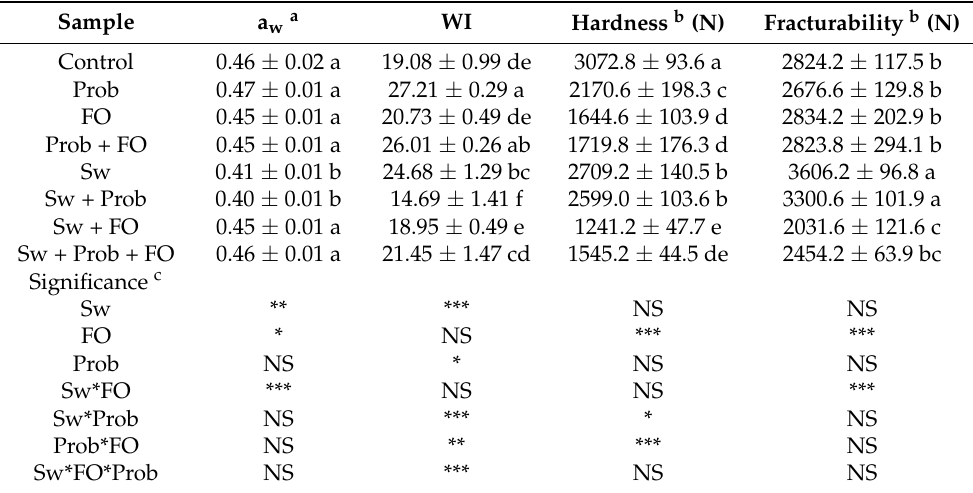
Table 2. Water activity (a w ), whiteness index (WI), and texture parameters’ (hardness and fracturabil- ity) values of sugar-free milk chocolate formulations with added probiotics and fish